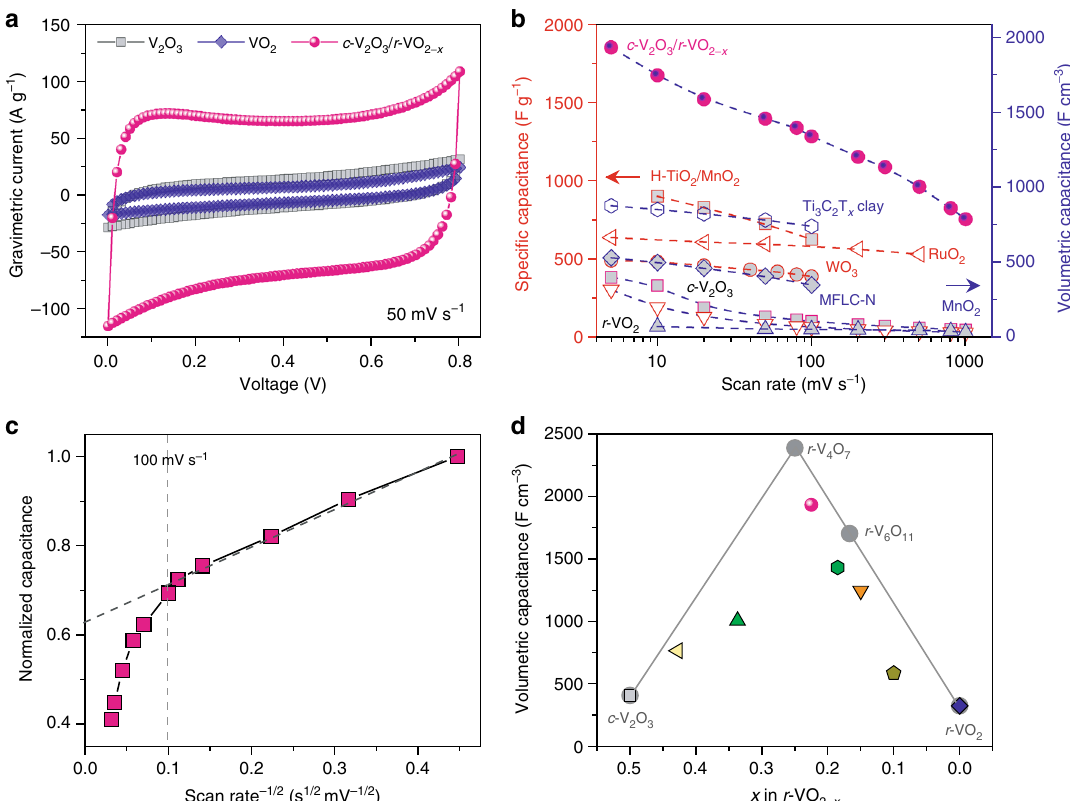
Fig. 4 Electrochemical characterization of electrodes in aqueous electrolyte. a Cyclic voltammetry (CV) curves of NP c -V 2 O 3 , r -VO 2 and c -V 2 O 3 / r -VO 2 − x ( x = 0.22) electrodes in three-electrode con fi guration at a scan rate of 50 mV s − 1 in 1 M Na 2 SO 4 . b Gravimetric and volumetric capacitances for NP c - V 2 O 3 , r -VO 2 and c -V 2 O 3 / r -VO 2 − x electrodes at various scan rates, comparing with the volumetric values previously reported for Ti 3 C 2 T x MXene clay 36 , N- doped mesoporous few-layer carbon (MFLC-N) 37 and bare MnO 2 electrodes 20 , as well as the gravimetric values of mesoporous RuO 2 9 , hydrogenated- TiO 2 /MnO 2 (H-TiO 2 /MnO 2 ) 19 and nanostructured hexagonal WO 3 38 . c Plot of normalized capacitance versus scan rate − 1/2 for the separation of diffusion-controlled intercalation pseudocapacitance from surface-controlled redox pseudocapacitance in the scan rates from 5 to 1000 mV s − 1 . d Evolution of volumetric capacitances of NP c -V 2 O 3 / r -VO 2 − x electrodes at a scan rate of 5 mV s − 1 as a function of x . The gray solid circles and lines are the theoretically volumetric capacitances for NP c -V 2 O 3 / r -VO 2 − x based on the atomic structures with x = 0, 0.167, 0.25 and 0.5, which correspond to r -VO 2 , metastable r -VO 2 − x and c -V 2 O 3 , (Fig. 4d). Whereas vanadium oxides generally suffer from cycling the redox pseudocapacitance that just accounts for about two fi fths of total capacitance. This indicates that the charge storage is instability, our NP c -V 2 O 3 / r -VO 2 − x electrode shows exceptional mainly contributed by the Na + insertion/extraction, which durability in long-term galvanostatic charge/discharge cycles behaves in a capacitive energy storage for the charge/discharge (Supplementary Figure 18), which are performed in a potential time of 8 s or longer. Whereas the intercalation pseudocapaci- window of 0 – 0.8 V at a current density of 80 A g – 1 in 1 M Na 2 SO 4 aqueous electrolyte (inset of Supplementary Figure 18a). After tance is conventionally limited by solid-state diffusion in 10,000 cycles, more than 90% capacitance still remained conventional TMOs 10, 11, 15 , it improves signi fi cantly the energy-storage density without compromise of rate performance (Supplementary Figure 18a). XPS analysis demonstrates that the in the NP c -V 2 O 3 / r -VO 2 − x electrodes because of the unique slight degradation of capacitance may result from the weeny microstructure of r -VO 2 − x , which offers both redox and change of surface valance state of r -VO 2 − x layer ( x = 0.23) intercalation pseudocapacitance with similarly facile kinetics. relative to that of the as-prepared one ( x = 0.22) (Supplementary Figure 18b), but not the dissolution of vanadium oxides which usually takes place in previously reported vanadium oxide electrodes (Supplementary Figure 18c) 41, 42 .